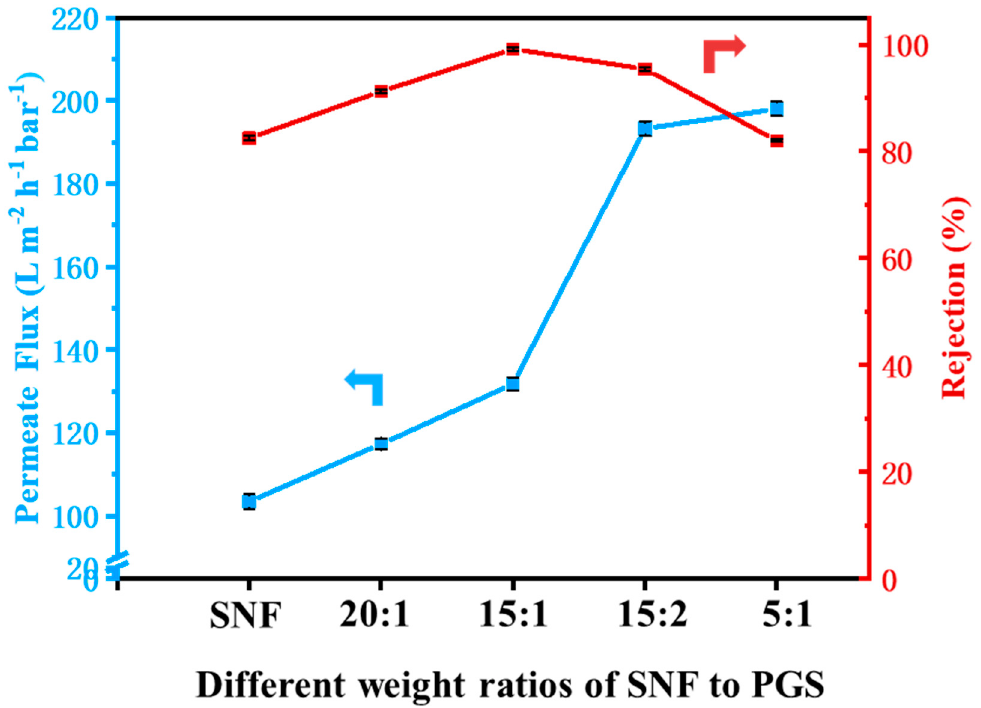
Figure 5. Separation performance of the different weight ratios of the SNF-PGS-G composite mem- branes for 100 ppm CR solution.